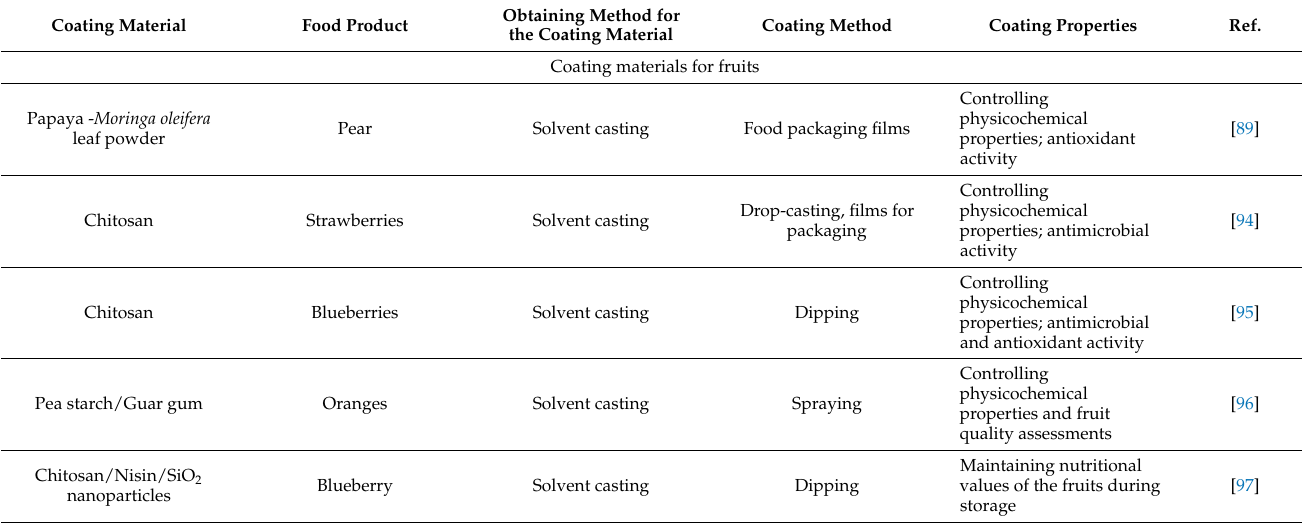
Table 3. Coating materials for food